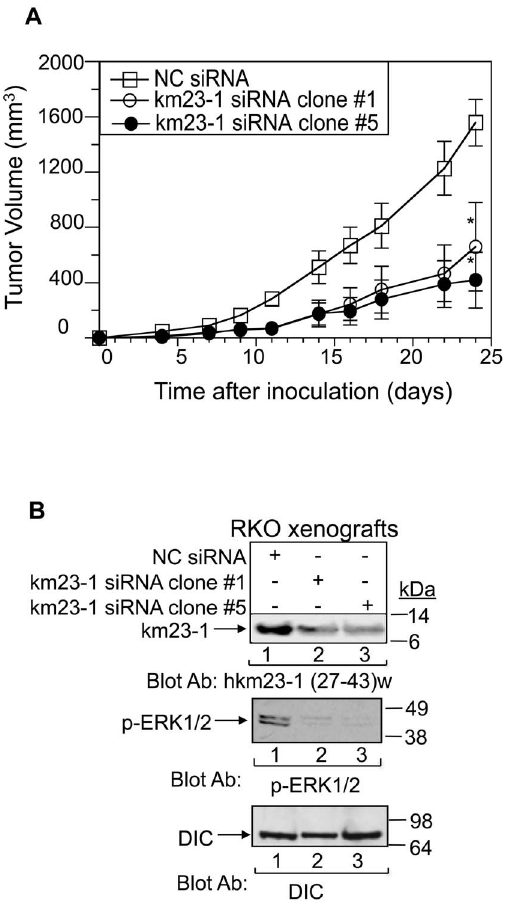
Figure 7. km23-1-siRNA blocks tumor growth of RKO cells in vivo . A: NC-siRNA RKO and km23-1siRNA RKO clone # 1 and # 5 cells (5 6 10 6 ) were inoculated subcutaneously behind the right anterior forelimb of nude mice (n=5). Tumor volumes were calculated as (length 6 width 2 )/2. *p , 0.05 compared to NC, ANOVA. B: At the termination of the study, ERK activation and km23-1 knockdown in RKO xenografts were confirmed by Western blotting using the indicated antibodies. DIC, loading control.